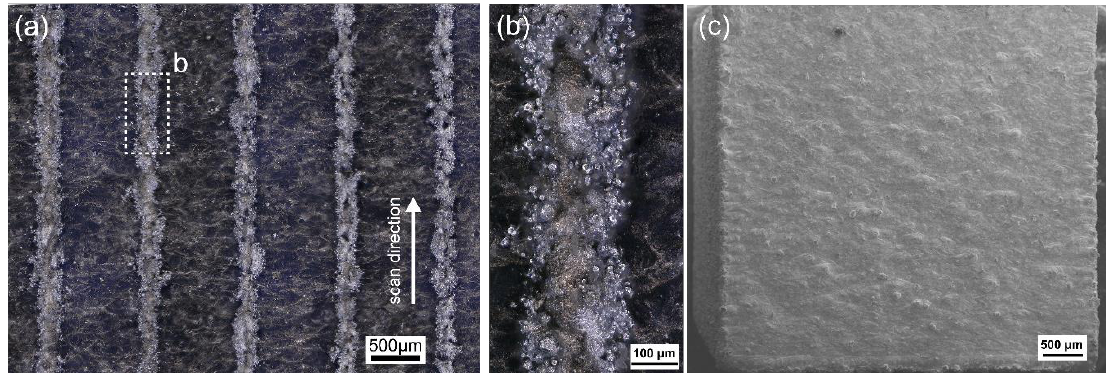
Figure 11. Surface quality of pure Zn by the LPBF; ( a , b ) single track, ( c ) top surface of a cube [28]. The processing window of high density over 99.5% was obtained in our previous work [27], represented by the gray area in Figure 12. The optimal linear energy input (laser power P divided by scanning speed V ) was in the range of 127–289 J/m. A much lower energy input could not melt the powder completely and resulted in the lack of